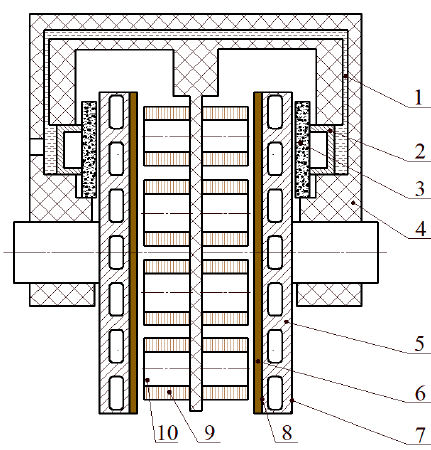
Figure 1. Structural diagram of electromagnetic-frictional integrated brake. 1, brake fluid; 2, brake piston; 3, brake pad; 4, caliper body; 5, integrated brake disc; 6, copper layer; 7, friction brake surface; 8, electromagnetic brake surface; 9, coil; and 10, iron core.